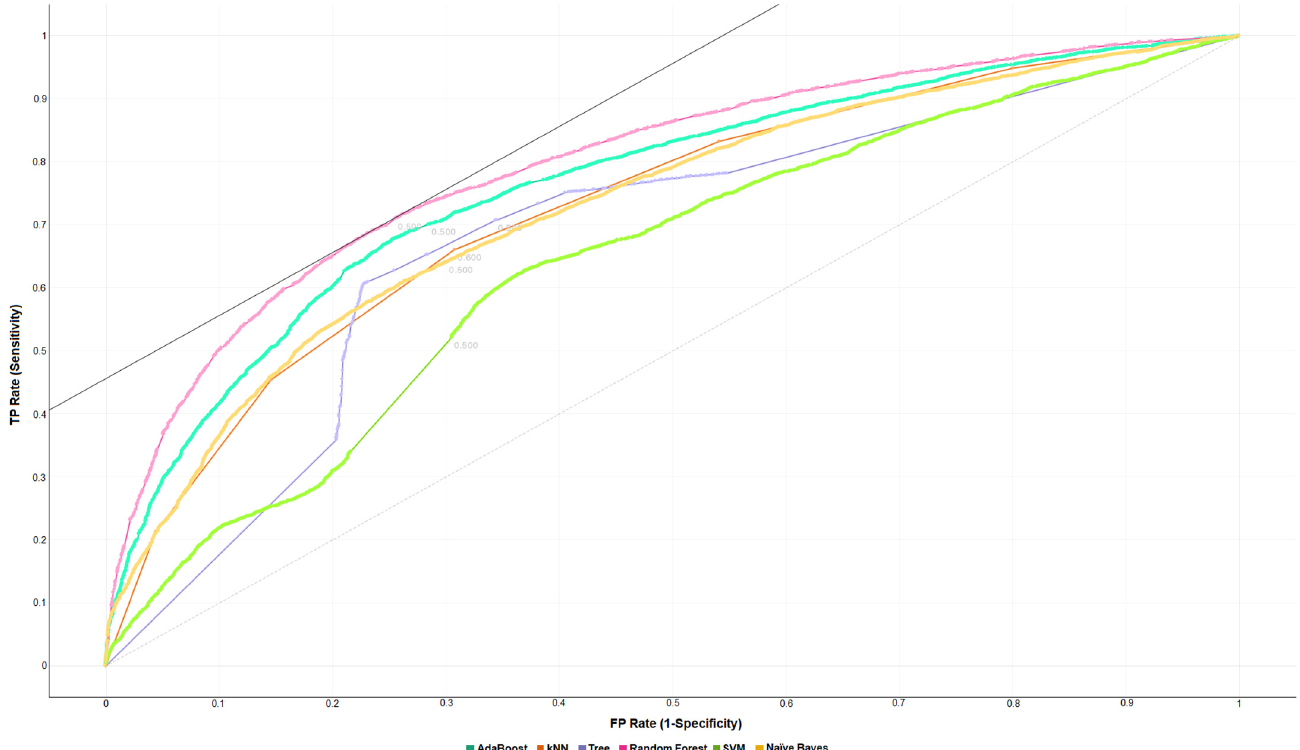
Figure 3. ROC curve for target = 0 with FP = 500, FN = 500, and target probability = 50.0%. The graph